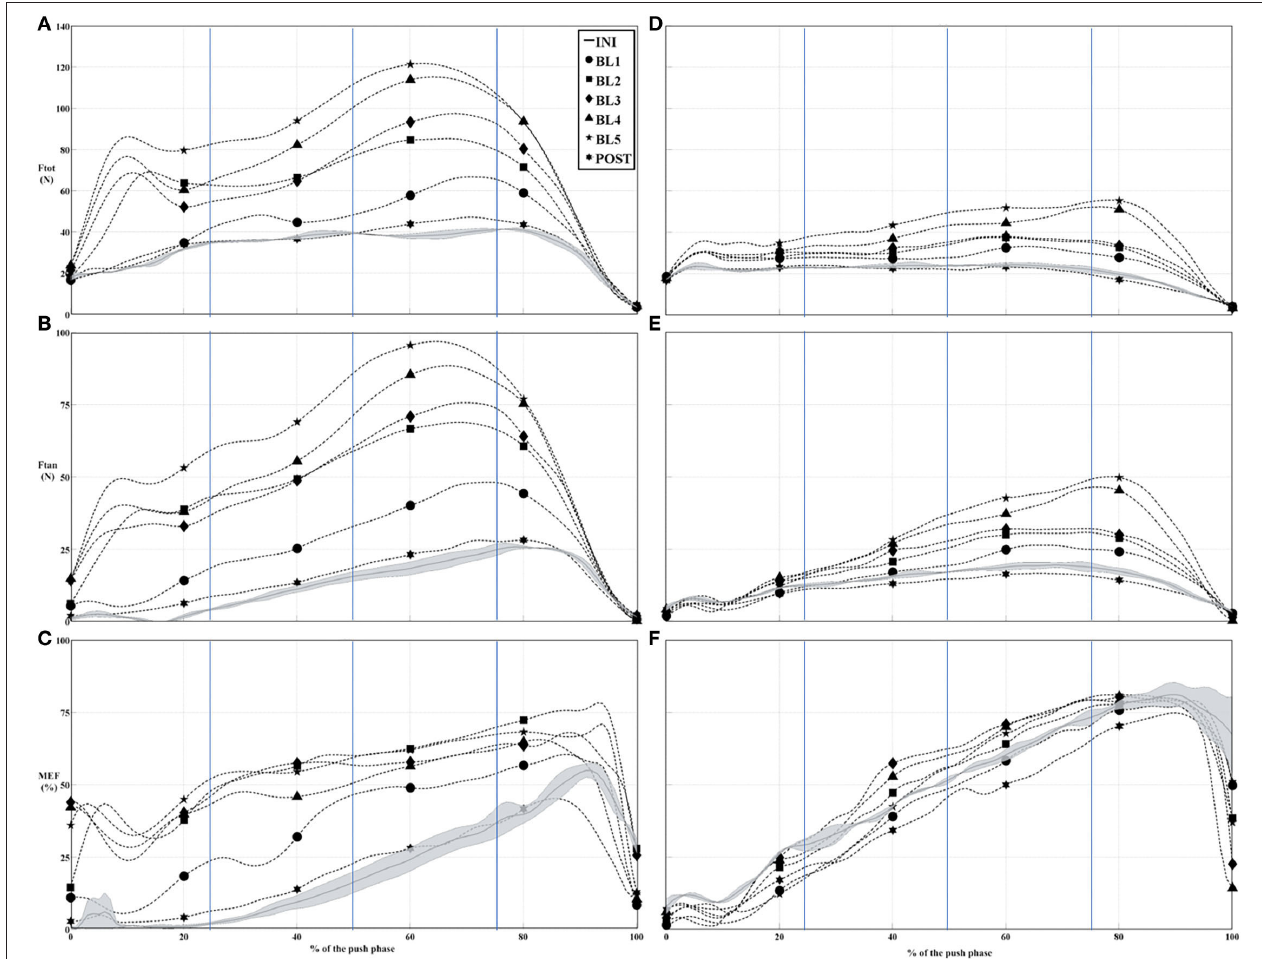
FIGURE 2 | Normalized time series of the Ftot, Ftan, and mechanical effective force (MEF) for a participant that was initially inefficient (A–C) and a participant that had initially high MEF (D–F) . Vertical lines indicate each quartile separation, i.e., 25, 50, and